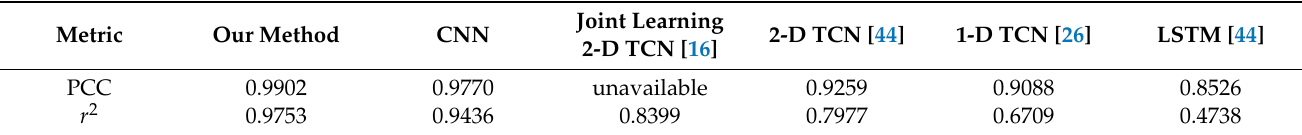
Table 2. Performance metrics of our method on a section of SEAM model compared with that of the state-of-the-art deep learning inversion methods.